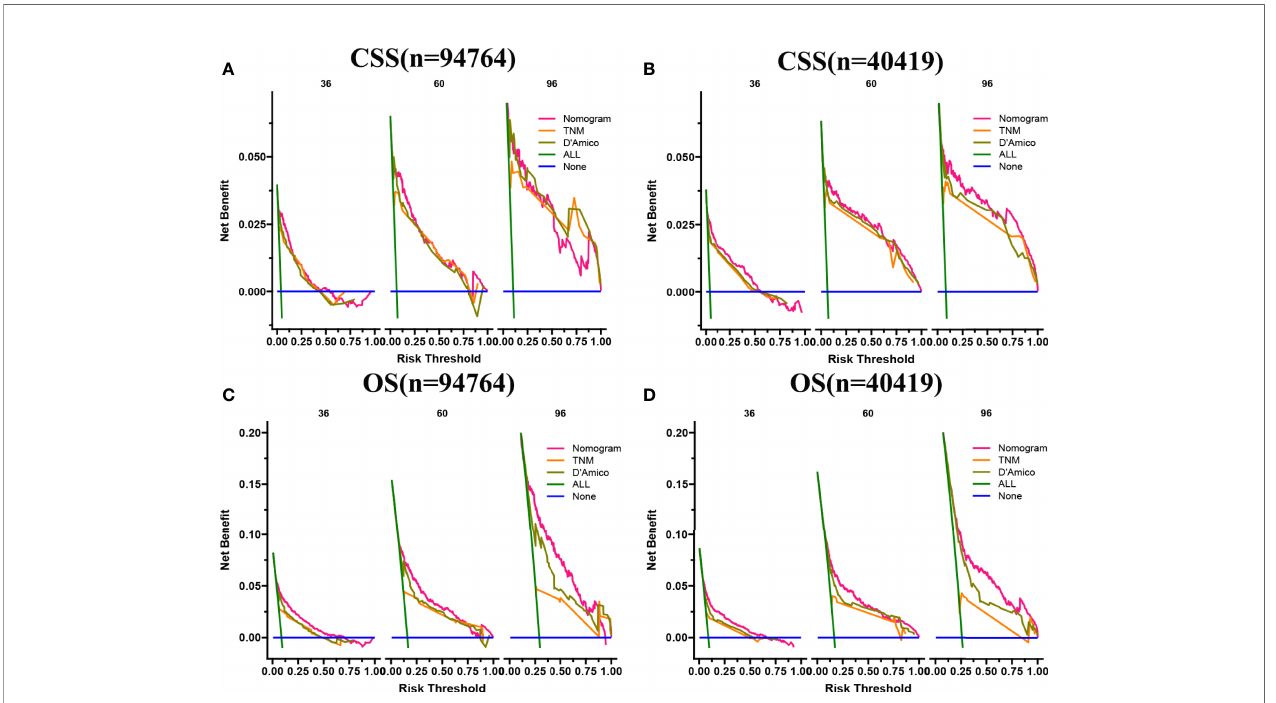
FIGURE 5 | DCA of the nomograms for predicting CSS and OS. (A) The nomogram for CSS at 3,5-year showed the best clinical potential value in the training set, while the nomogram for CSS at 8-year had no apparent advantages over the other two. (B) In the validation set, the nomogram for CSS at the 3,5,8-year showed the best clinical potential value, followed by the D ’ Amico risk strati fi cation system and TNM staging system. (C, D) The nomogram for OS at 3-,5-,8-year showed the best application potential in both the training and validation sets, followed by D ’ Amico risk strati fi cation and TNM